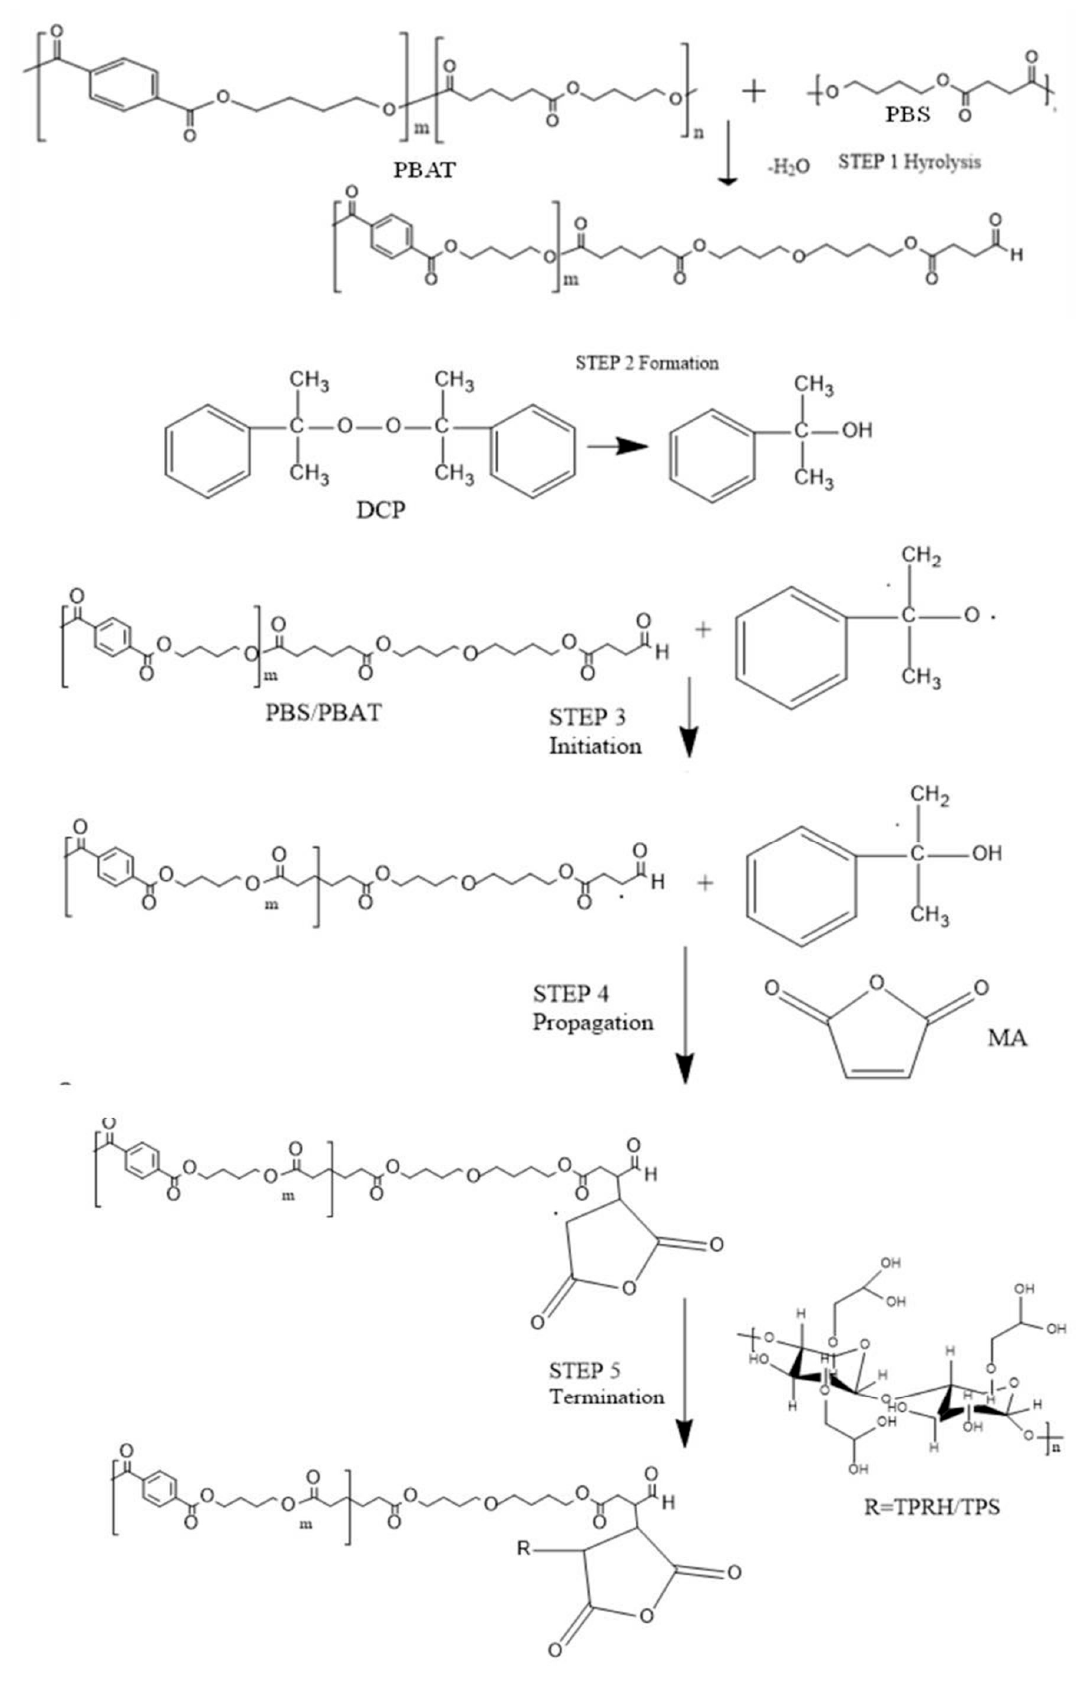
Figure 2. The mechanism between maleic anhydride, DCP, PBS, PBAT, and TPRH/TPS.